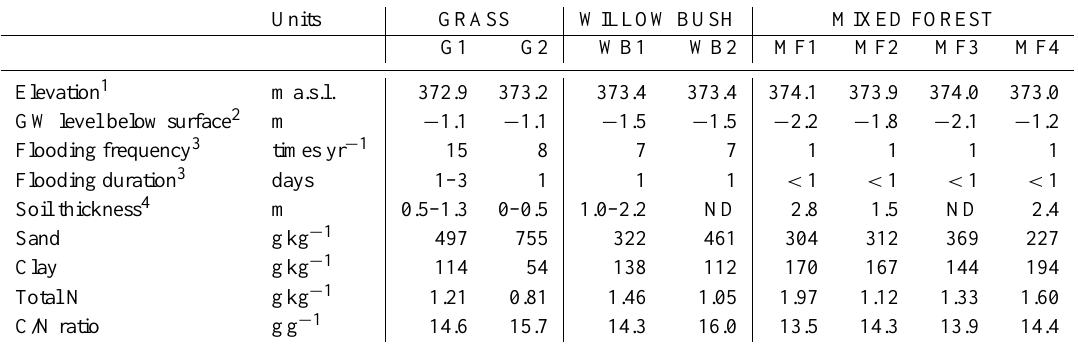
Table 1. Hydrogeological characteristics and soil properties of sampling plots within different FPZs. Soil properties are given for the top 10cm of soil.